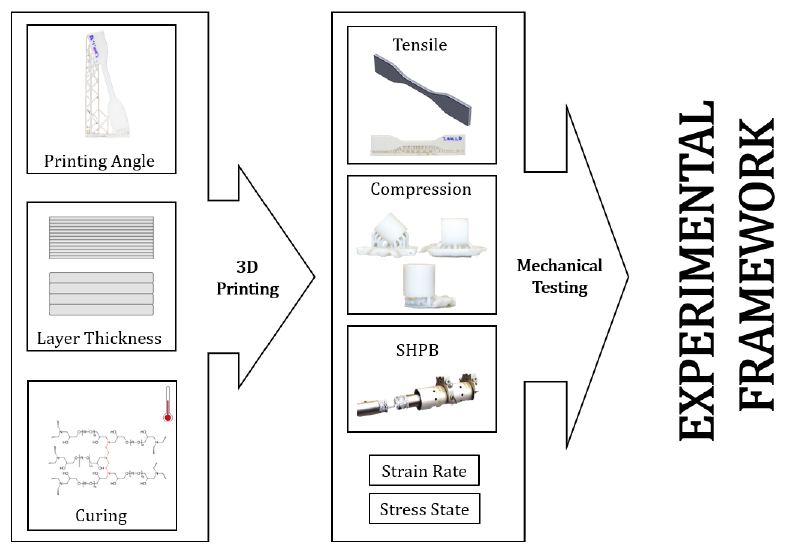
Figure 1. Experimental framework to study and characterize materials printed by SLA.